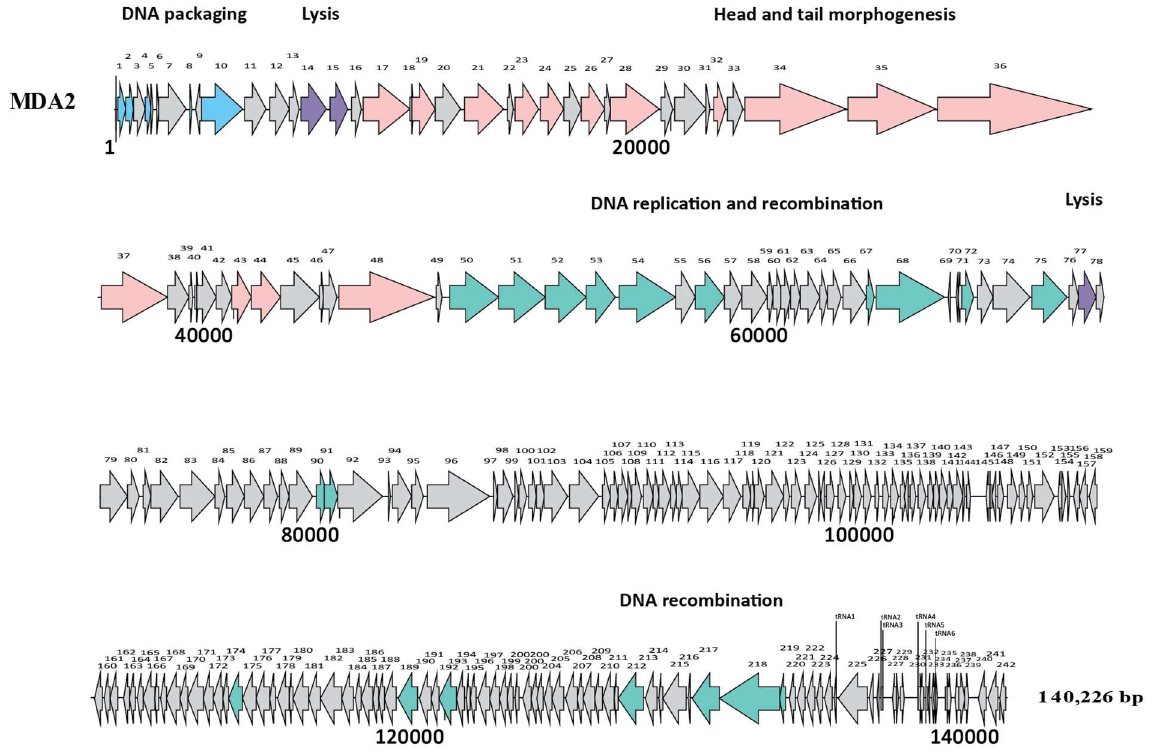
Figure 3. Genome structure of MDA2 phage. Each arrow represents an ORF. Colors represent different genomic regions including the DNA packaging (blue), the head and tail morphogenesis genes (pink), host lysis genes (purple), and the replication–transcription region (green). Grey arrows represent genes coding for hypothetical proteins. tRNAs are represented by vertical lines.